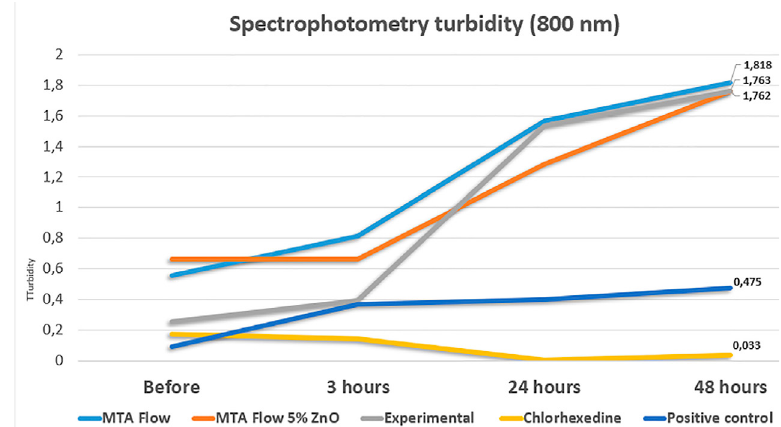
Figure 5- Spectrophotometric representation of the tested compositions presenting significantly higher values of turbidity (p<0.010) after discounting the solubility in comparison to positive control and chlorhexidine. Chlorhexidine presented the lowest values of turbidity after 3 hours